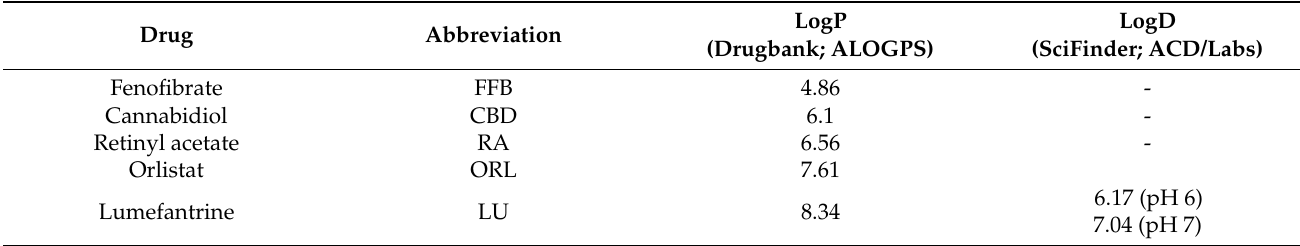
Table 1. Calculated octanol-water partition and distribution coefficients (LogP and LogD) of the drugs under investigation. (Source; calculated